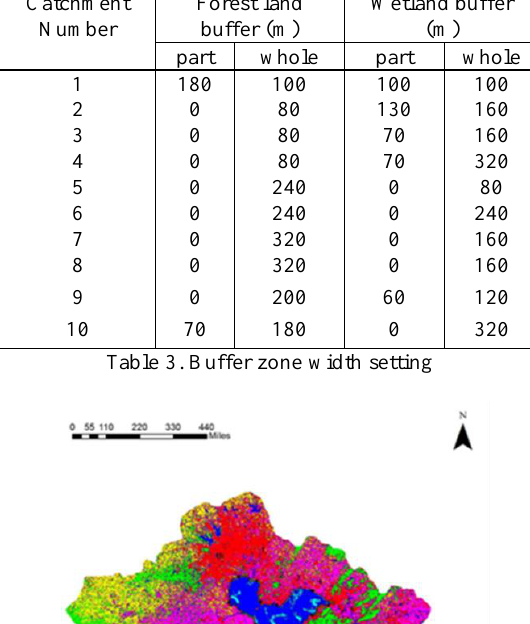
Figure 5. Division of catchment area in the Chaohu Lake basin